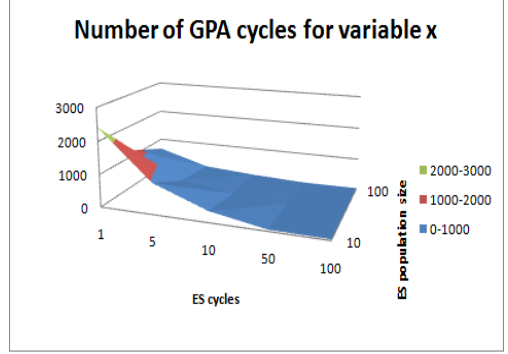
Fig. 3: Number of iterations of encapsulating GPA for x variable depending on ES.